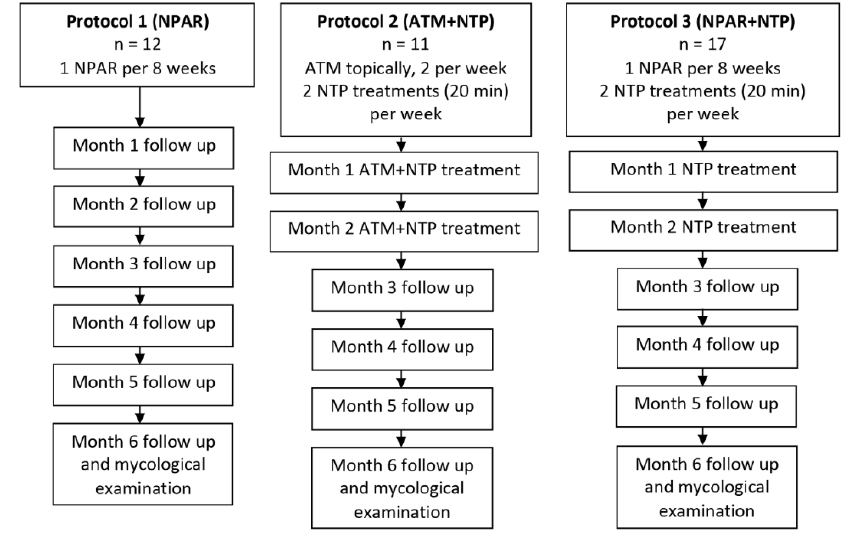
Figure 4. Flowchart of the study design. NPAR, nail plate abrasion and refreshment; ATM,